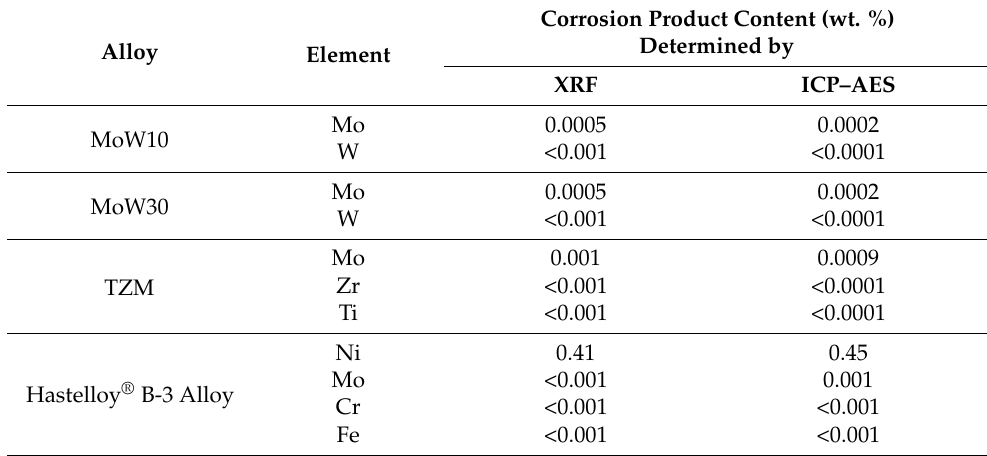
Table 3. Content of the corrosion products in Bi–Li alloys after 100 h contact with Mo- and Ni-based alloys at 650 °C.